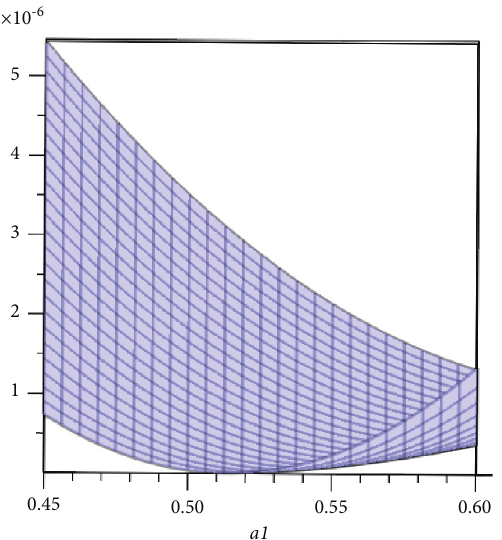
Figure 11: The projection of the graph of the data ( a